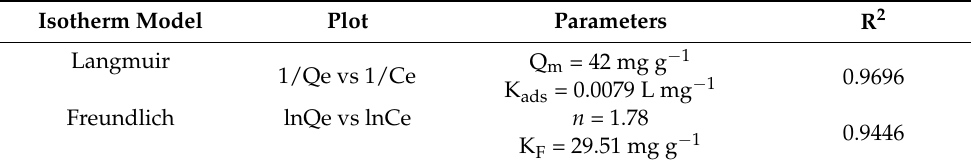
Figure 10. Transformation of ( a ) Langmuir; ( b ) Freundlich adsorption isotherm of RB5 decolorization using 0.1Fe-TiO 2 -300. Table 2. Summary of isotherms constants.